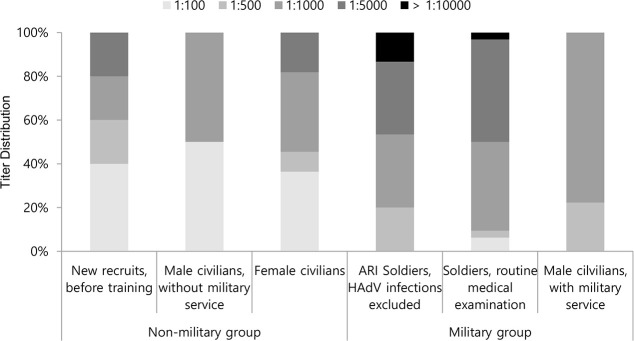
Titer distribution of neutralizing antibody against HAdV-55 according to population groups.